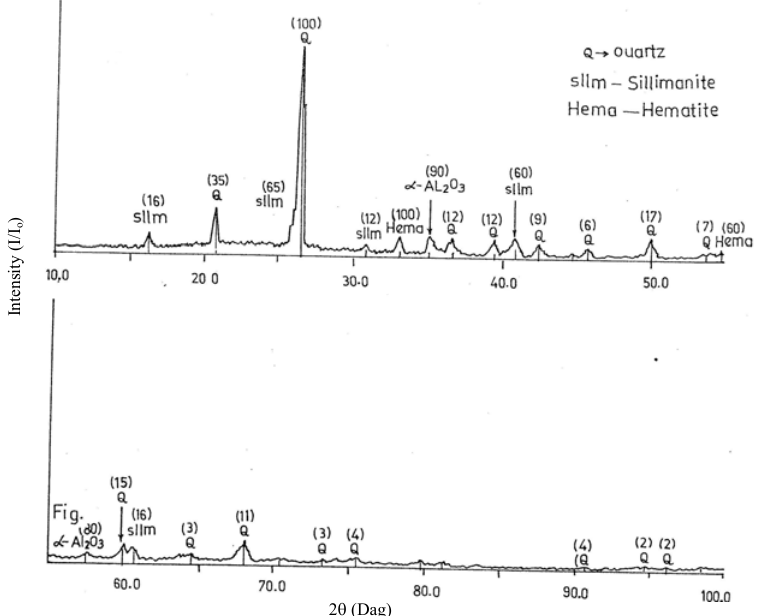
Figure 1. X-ray diffraction of fly ash